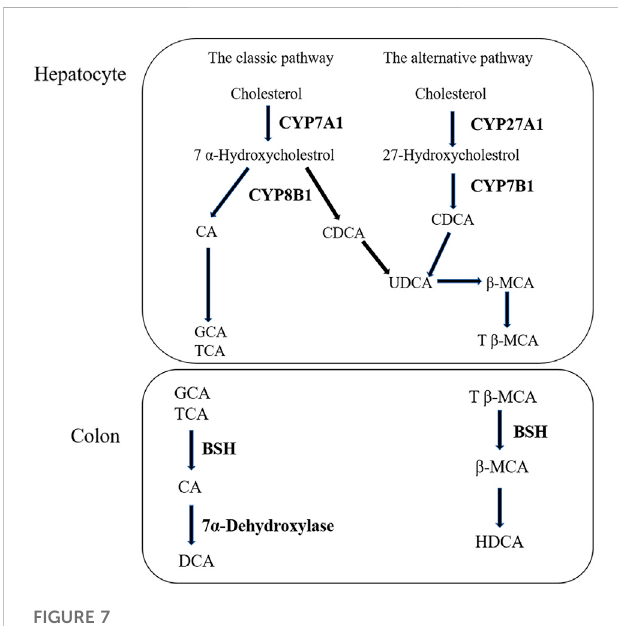
The process of bile acid